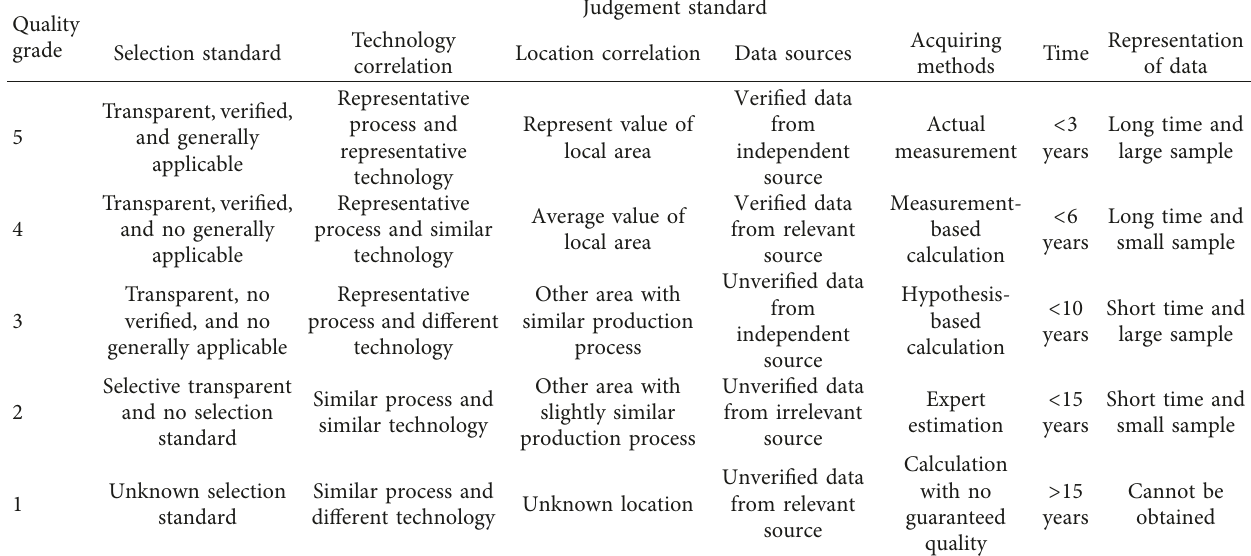
Table 1: Data quality evaluation